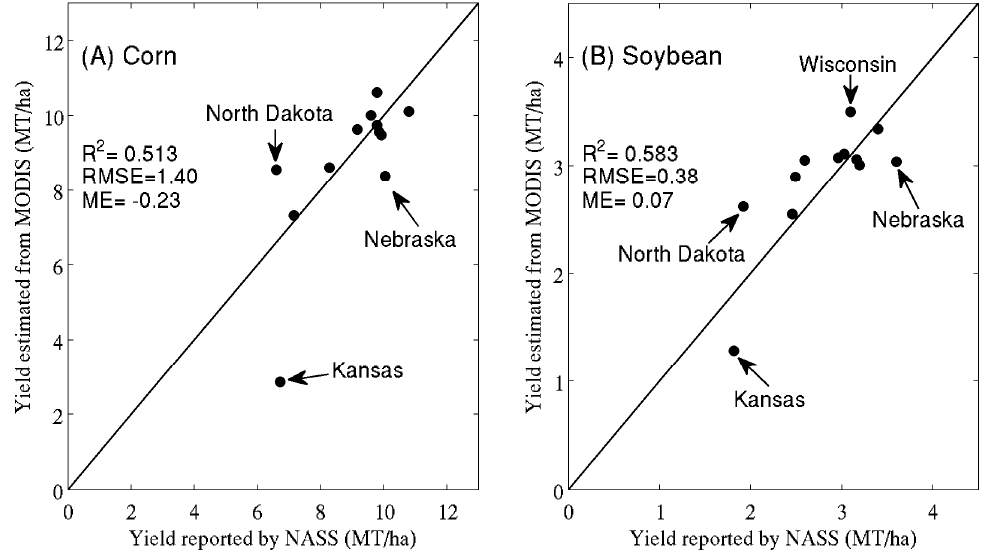
Figure 7. Comparisons between crop yields estimated from MODIS data and reported by the NASS for states in the Midwestern US. The black line is the 1:1 line. ( A ) Corn; ( B ) Soybean.